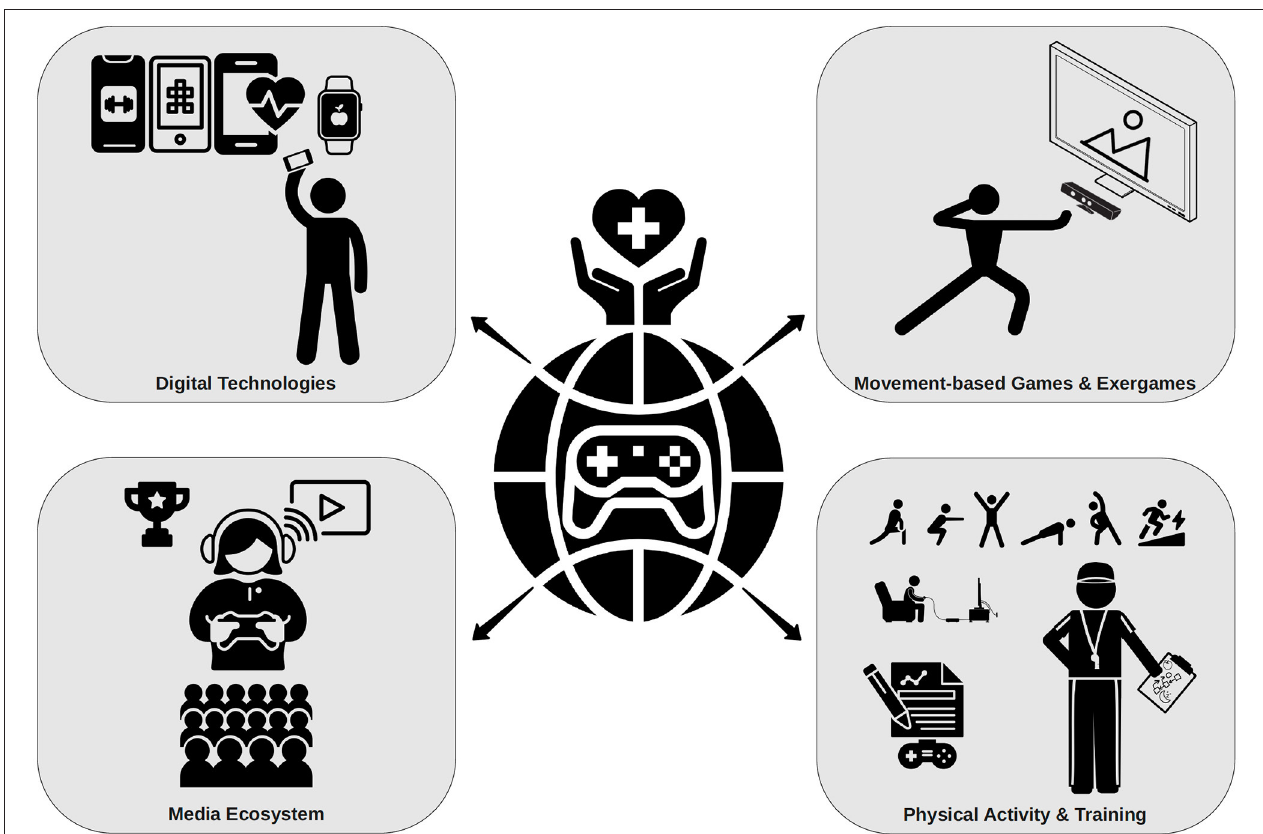
FIGURE 1 | Overview of potential health promotion strategies in